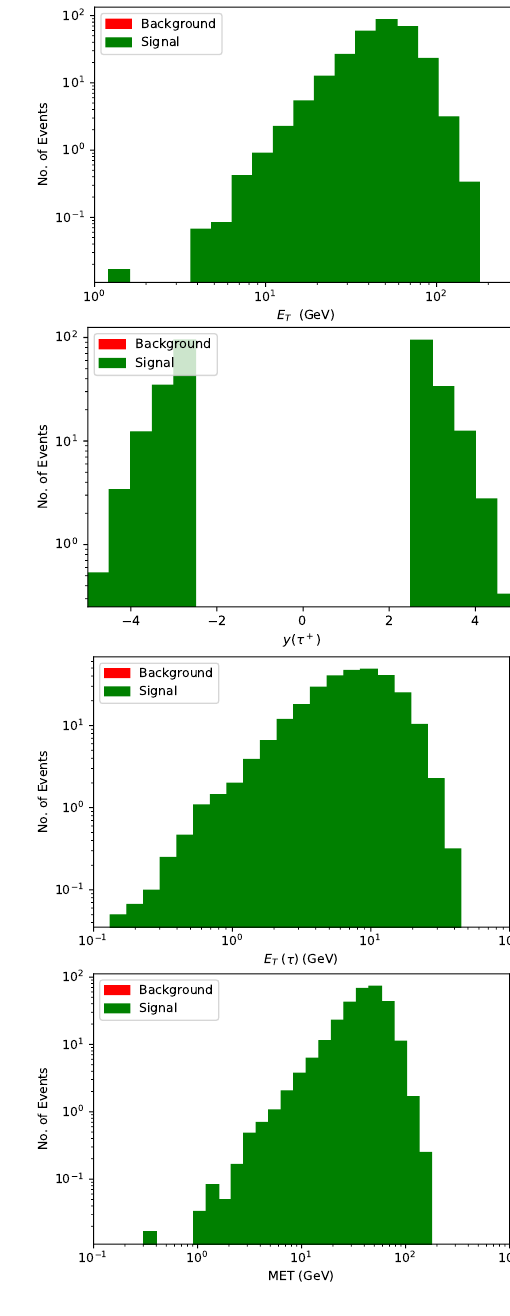
Figure 7 . Parton level event distributions for pp → H + an integrated luminosity of 3000 fb − 1 along with the SM background (in red). (Left column, top to bottom): the total transverse energy E T , the rapidity y , the total transverse energy of the τ + lepton, E T ( τ + ) , and the missing transverse energy /E the same distributions after the selection criteria of | y | > 2 . 5 , which eliminates the